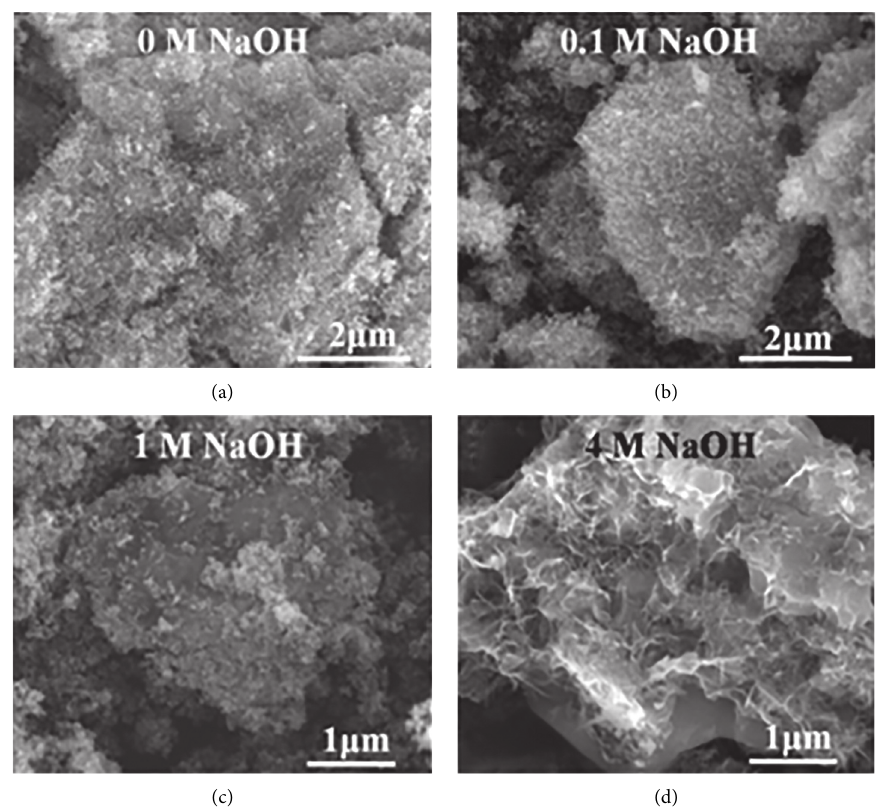
Figure 6: Effect of NaOH concentration on the morphology of the samples. (a) 0 M. (b) 0.1M. (c) 1M. (d)